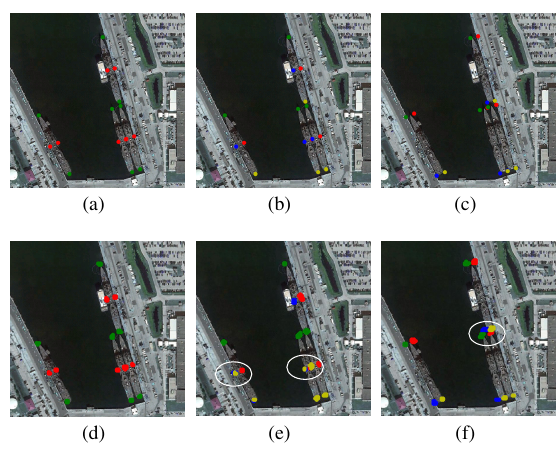
Figure 7. The results of different keypoint definitions and keypoint learning methods. The same color of the keypoints represents that the keypoints are assigned to the same heatmap for learning. For simplicity, the center points are not visualized. objects can better represent a ship.